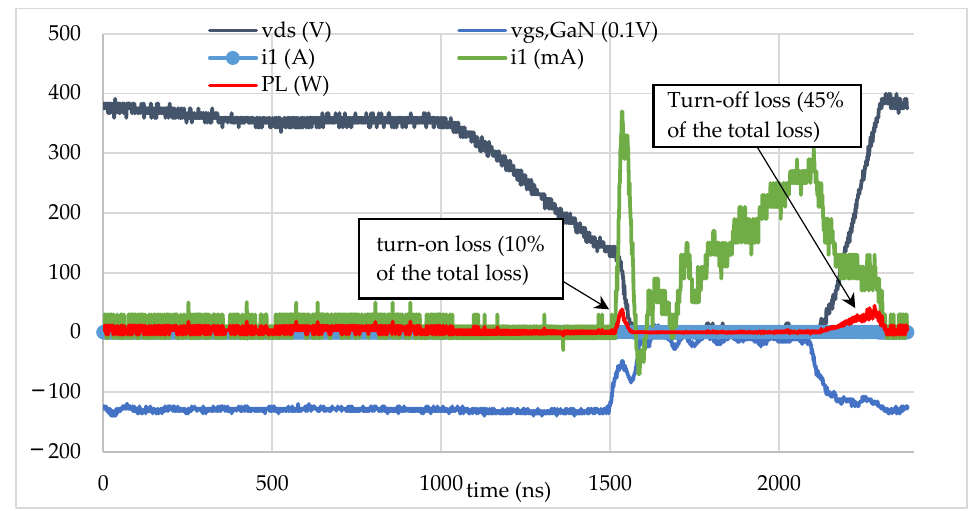
Figure 15. DCM response of Type 2B at switching frequency fs = 420 kHz.